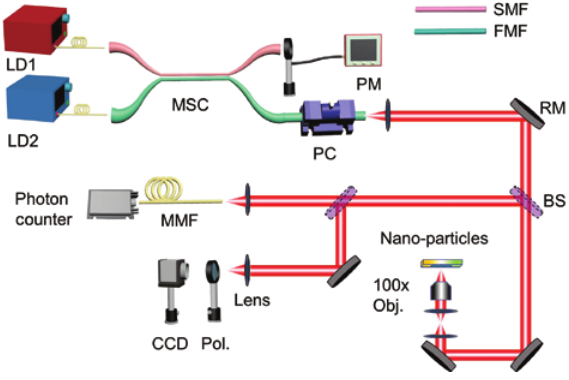
Figure 7: Confocal microscope system for multiplexing and detecting donut and Gaussian